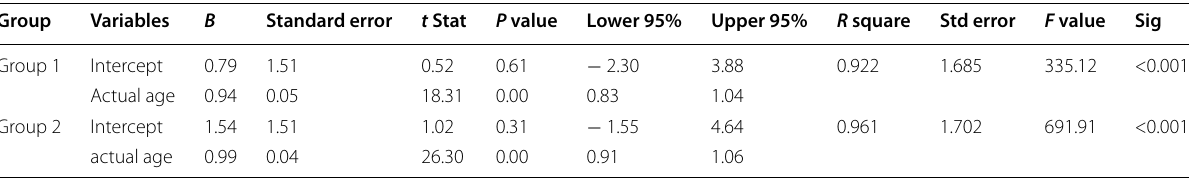
** Statistically highly significant ( p <0.01)